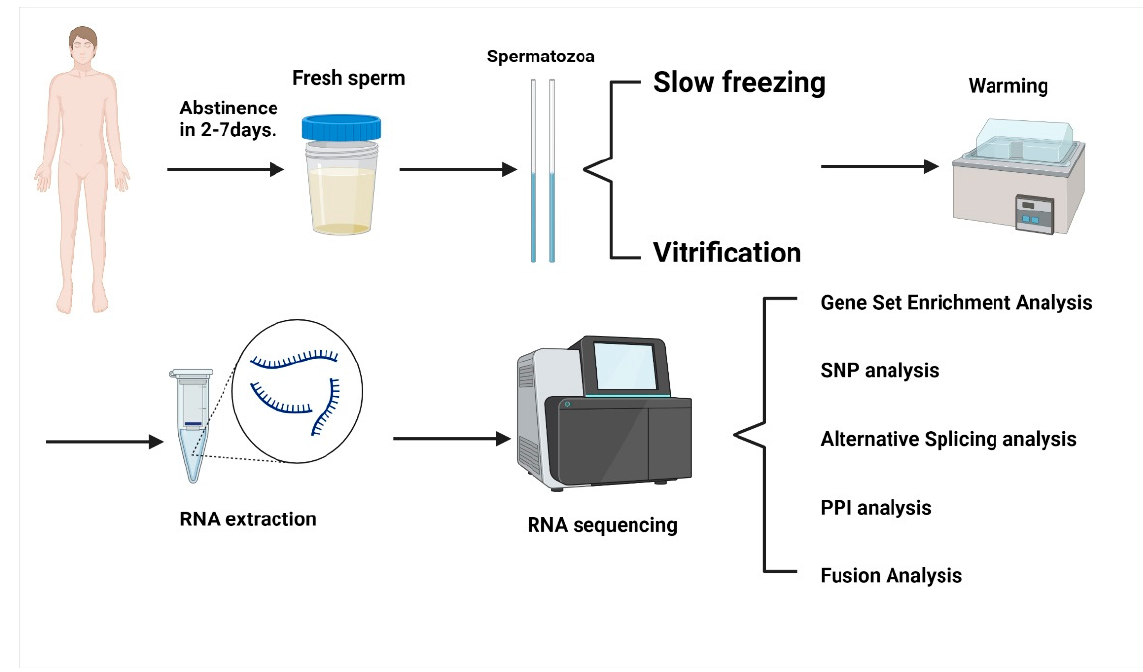
Figure 4. Flow chart of experimental methodology.